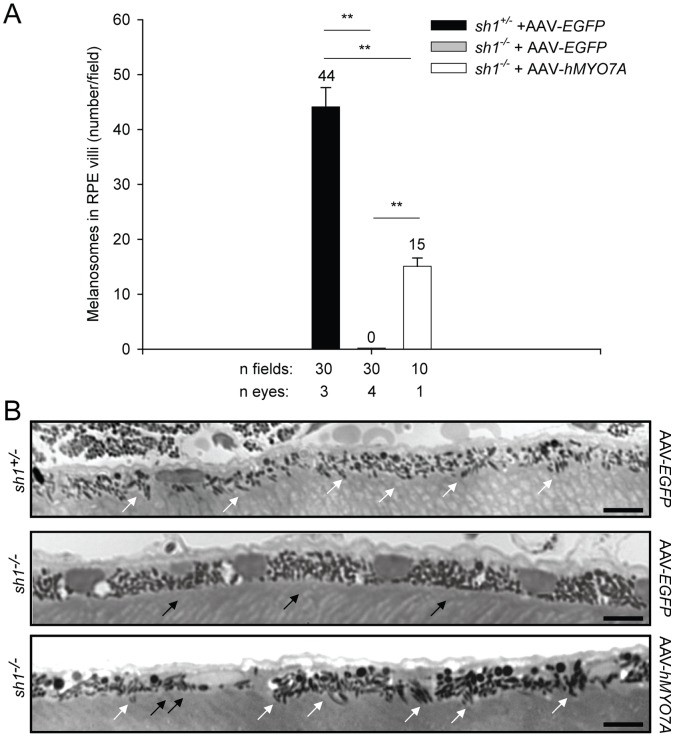
Subretinal delivery of AAV encoding human Myo7a rescues melanosome localization in sh1−/− RPE villi.
A
. Quantification of melanosome localization to the RPE villi of sh1 mice at 4 months following the treatment. The quantification is depicted as the mean number of melanosomes/field. **p value<0.001. More details on the statistical analysis including specific statistical values can be found in the Statistical analysis paragraph of the Materials and Methods section. B. Representative pictures of semi-thin sections stained with Epoxy tissue stain from pigmented sh1 mice at 4 months following the injections. White arrows point at melanosomes correctly localized to the RPE villi, while black arrows point at mis-localized apical melanosomes. The scale bar is 100 µm. A–B: AAV-hMYO7A: AAV2/5-CMV-hMYO7A; AAV-EGFP: AAV2/5-CMV-EGFP.